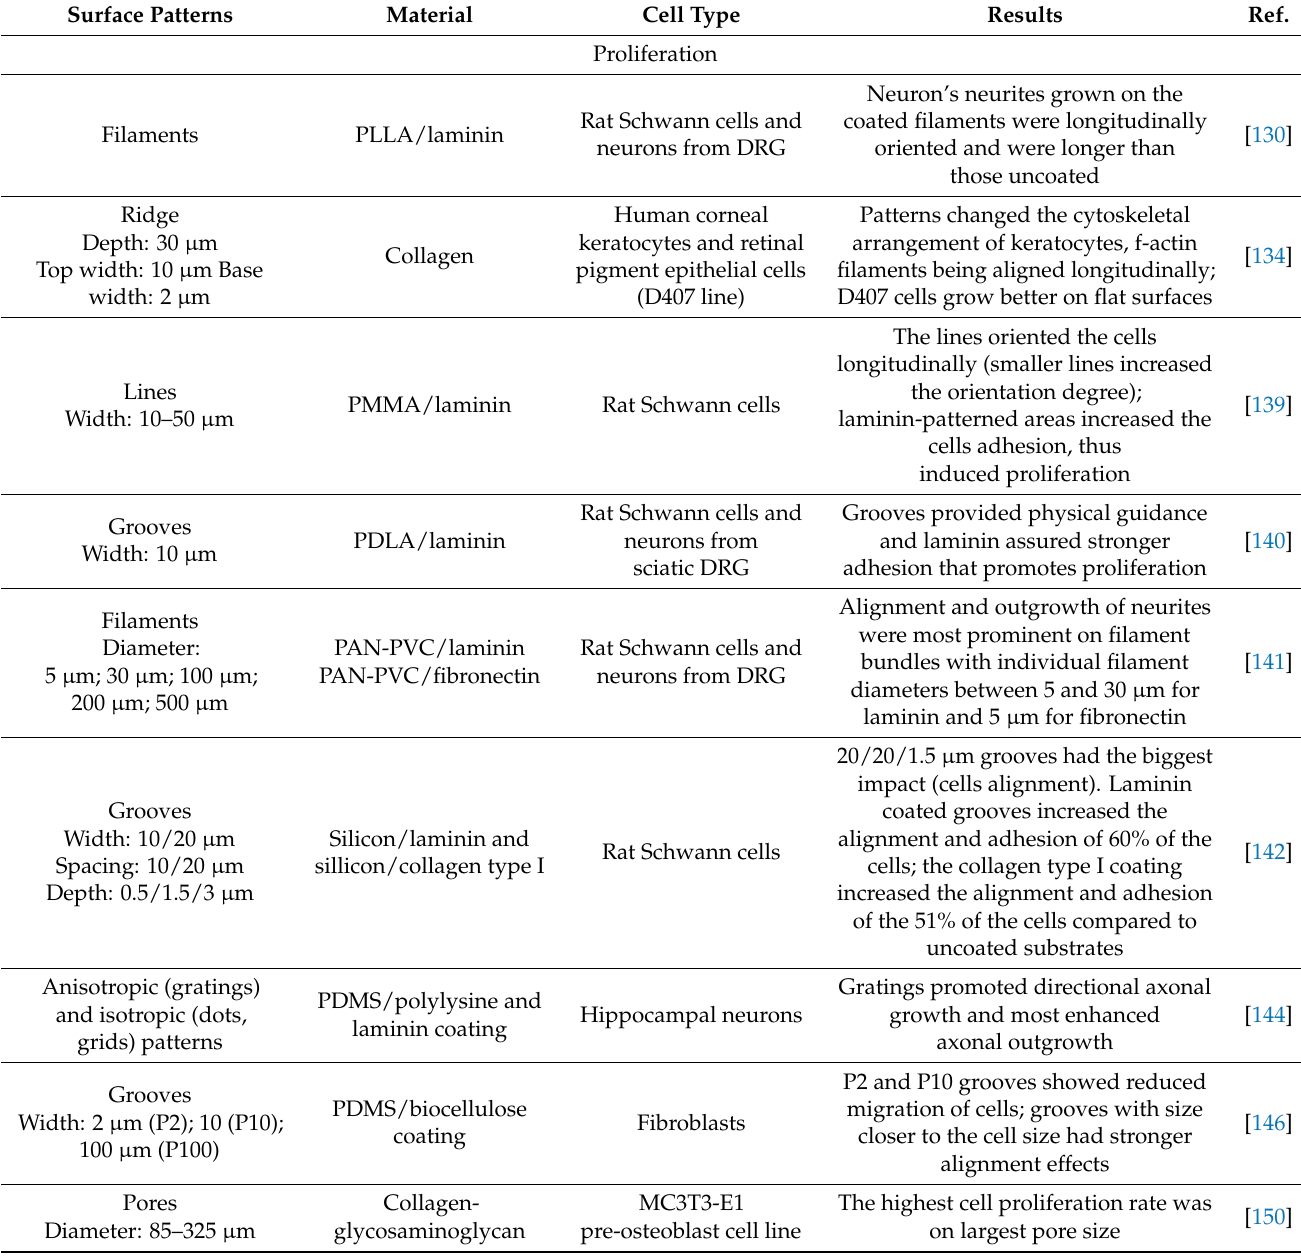
Table 2. Characteristics of several topographies that impact cell